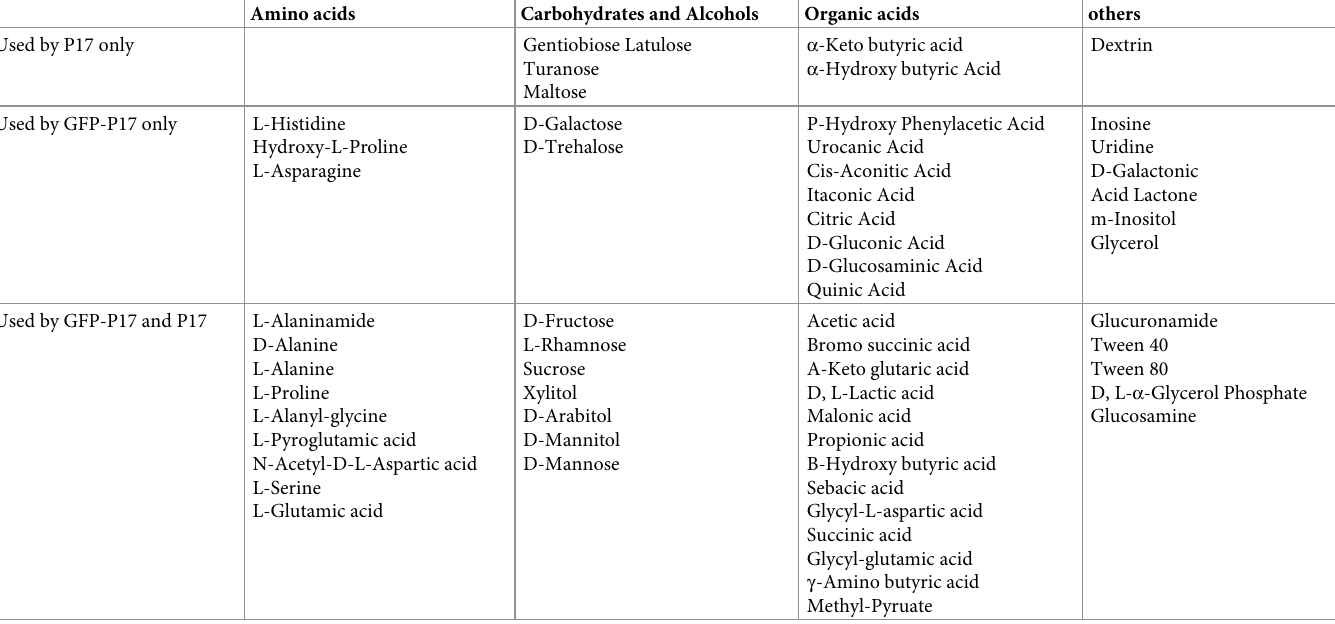
Table 1. Comparison of carbon substrate utilization pattern of GFP-P17 and P17.